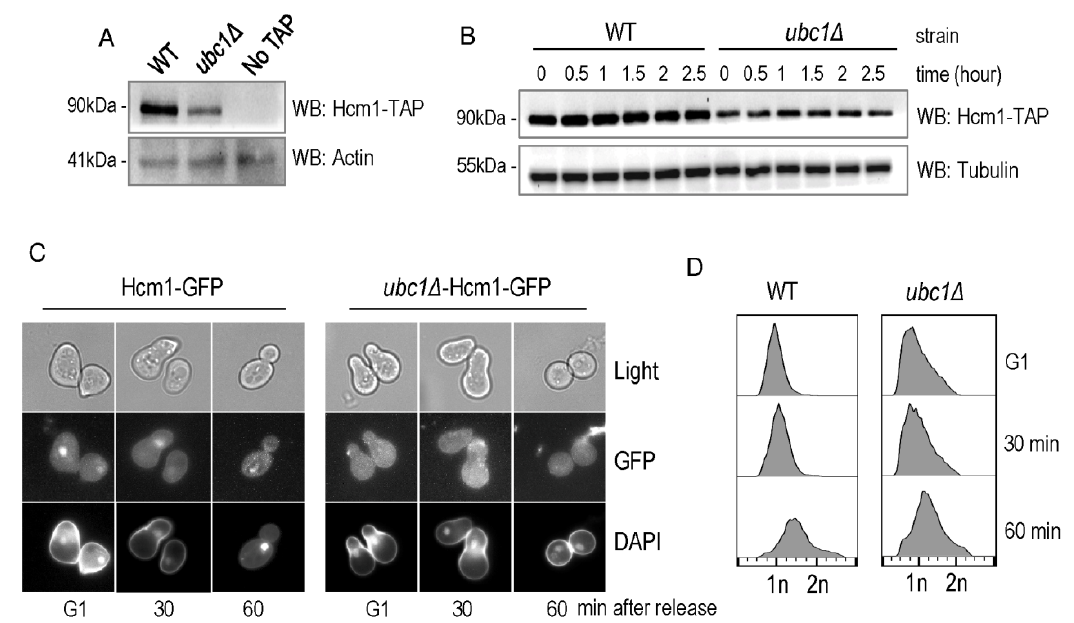
FIGURE 6. Hcm1 is impaired in its cell cycle dependent nuclear import upon deletion of Ubc1. (A) Equal numbers of early logarithmic phase cells from WT and ubc1 Δ strains with or without an endogenous Hcm1-TAP tag were lysed followed by TAP Western analysis. (B) Assessment of Hcm1 protein stability over 3 hours in WT and ubc1 Δ strains in the presence of cycloheximide, added at time (0), in 2% glucose. Equal cell numbers were removed at the indicated time points with 30 μg protein loaded. (C) Fluorescent microscopy of genomically integrated GFP- tagged Hcm1 expressed from its endogenous promoter in isogenic WT and ubc1 Δ strains. Both strains were arrested in G1 followed by re- lease, with cells collected at the indicated timepoints. (D) Flow cytometry analysis of cells collected at the timepoints in (A), highlighting the relative proportion of replicated DNA (2n) upon release from